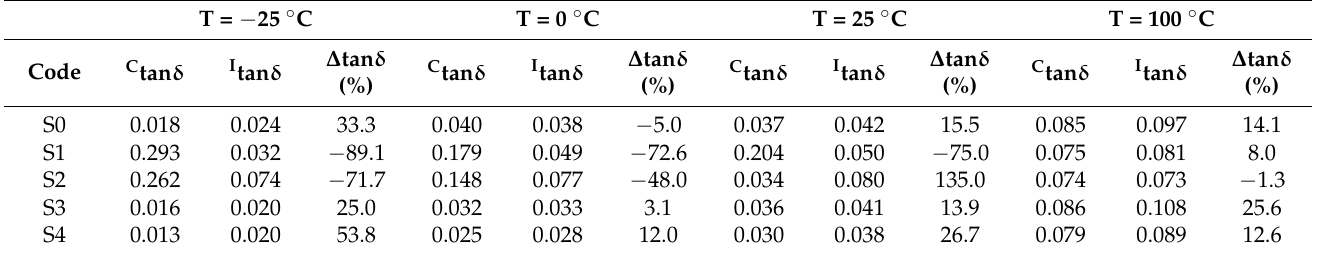
Table 8. Damp Factor (tan δ ) obtained from the indicated molded compounds obtained under Compression ( C tan δ ) and Injection conditions ( I tan δ ) for the indicated